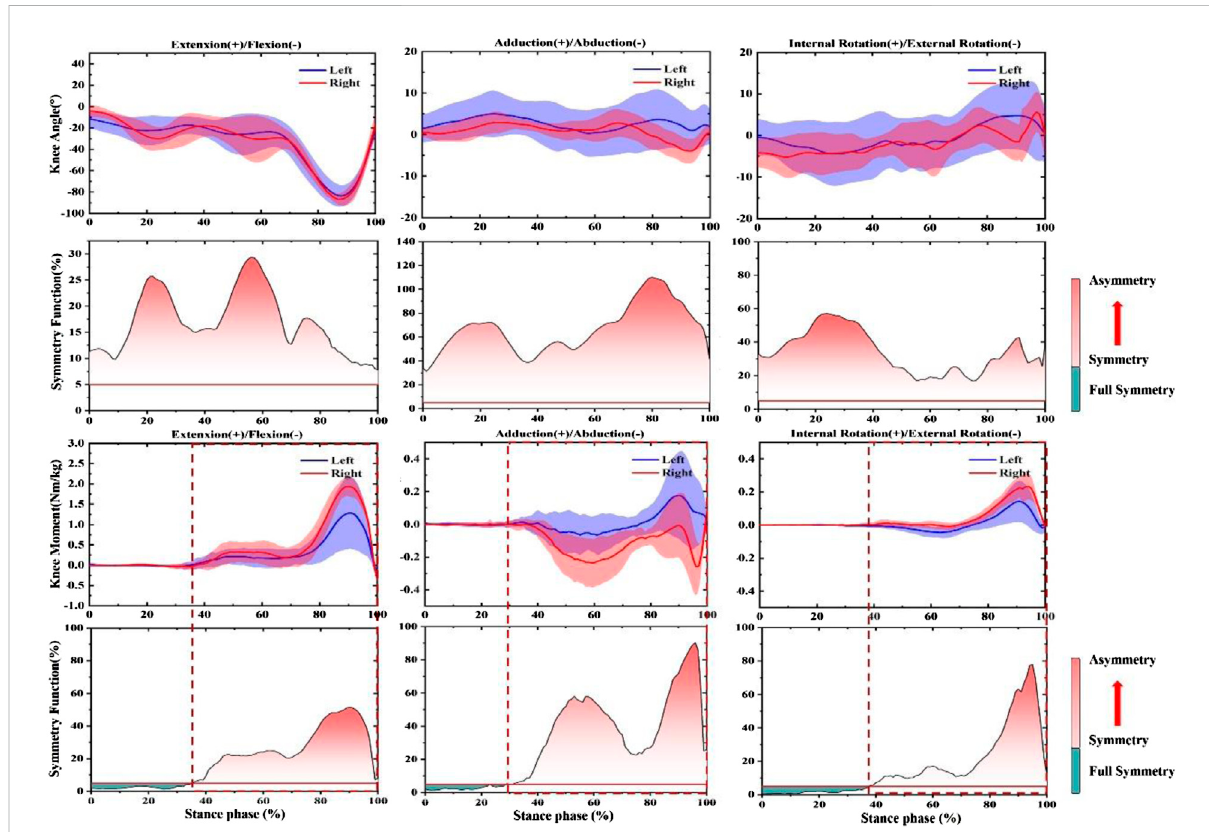
FIGURE 2 Illustration of SF degree in bilateral knee joint angle and moment during push-off stage before prolonged-running protocol for the CMJ test. Note: The red fi ll represents the degree of asymmetry, and the darker the color, the more asymmetry. The green fi ll represents full